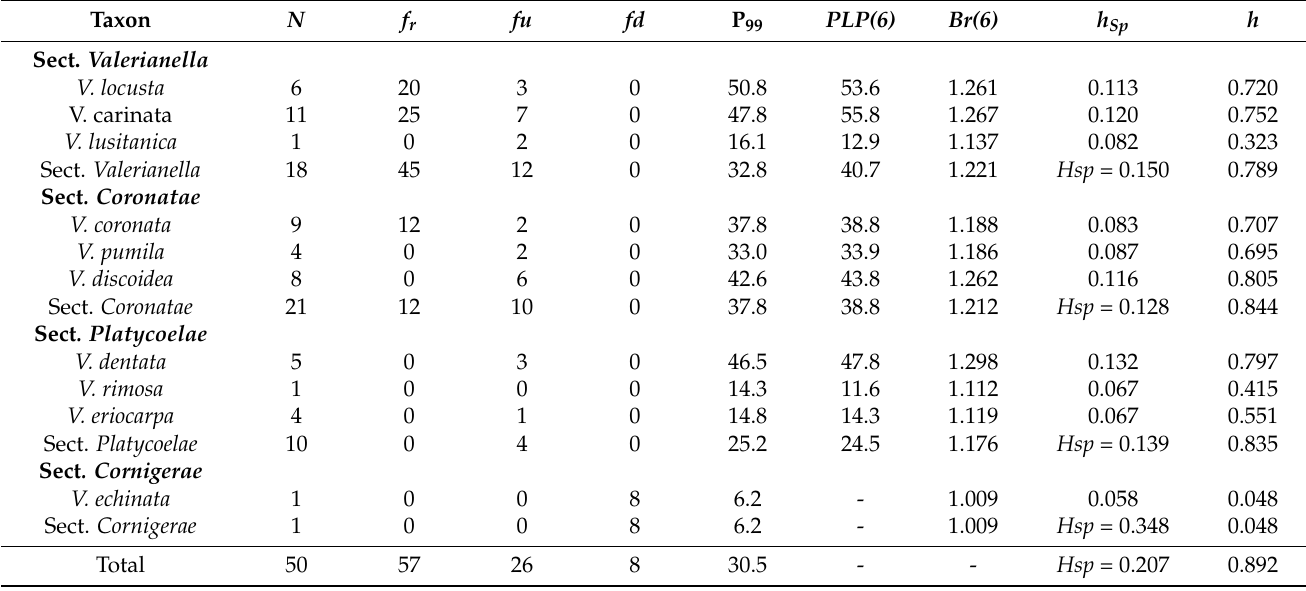
Table 2. Genetic diversity values of the 10 Iberian species of Valerianella studied. Number of populations studied ( N ), number of rare fragments ( fr ), number of unique fragments ( fu ), number of diagnostic fragments ( fd ), percentage of polymorphic loci at the 99% criterion ( P99 ), percentage of polymorphic loci at the 1% criterion after rarefaction ( PLP ), band richness after rarefaction ( Br ), Bayesian diversity within species ( hsp ) and between species ( Hsp ), Nei ´ s genetic diversity ( h